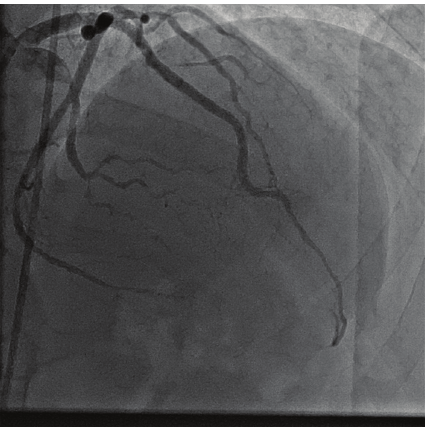
Figure 4: Final result of the primary angioplasty, showing angio- graphic